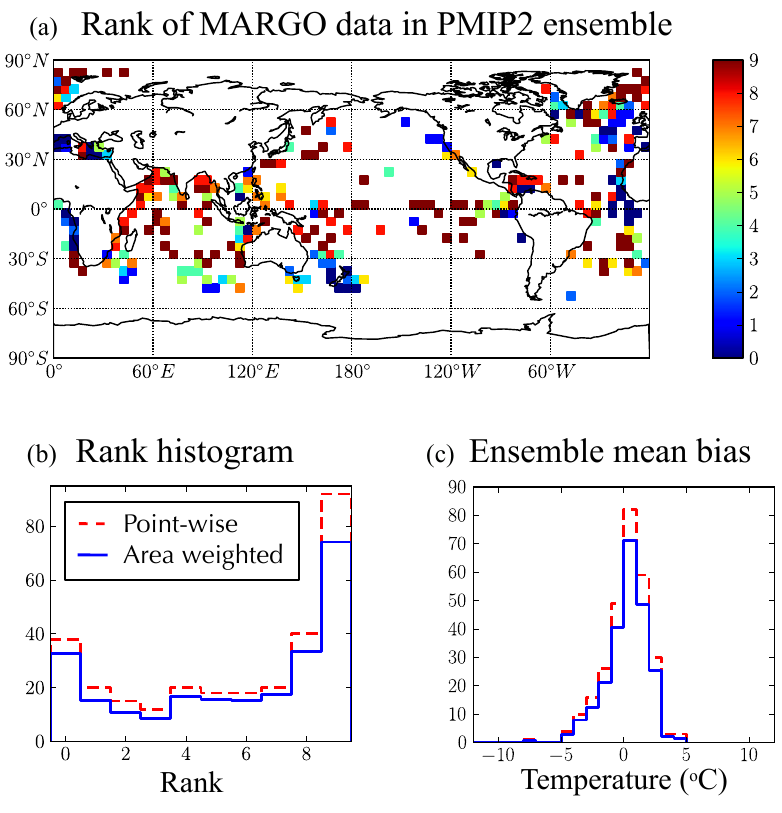
Fig. 6. (a) The rank of the MARGO data in the PMIP2 SST for the whole globe. (b) Area-weighted rank histogram of the ranks in plot (a) . High rank (red on the colour scale) indicates that MARGO is warmer at the LGM than the ensemble. (c) The histogram of the difference between the PMIP2 SST ensemble mean and the MARGO data for each data point in plot (a) . Both area-weighted and point-wise rank histograms are shown. The uncertainties in the MARGO data are not taken into